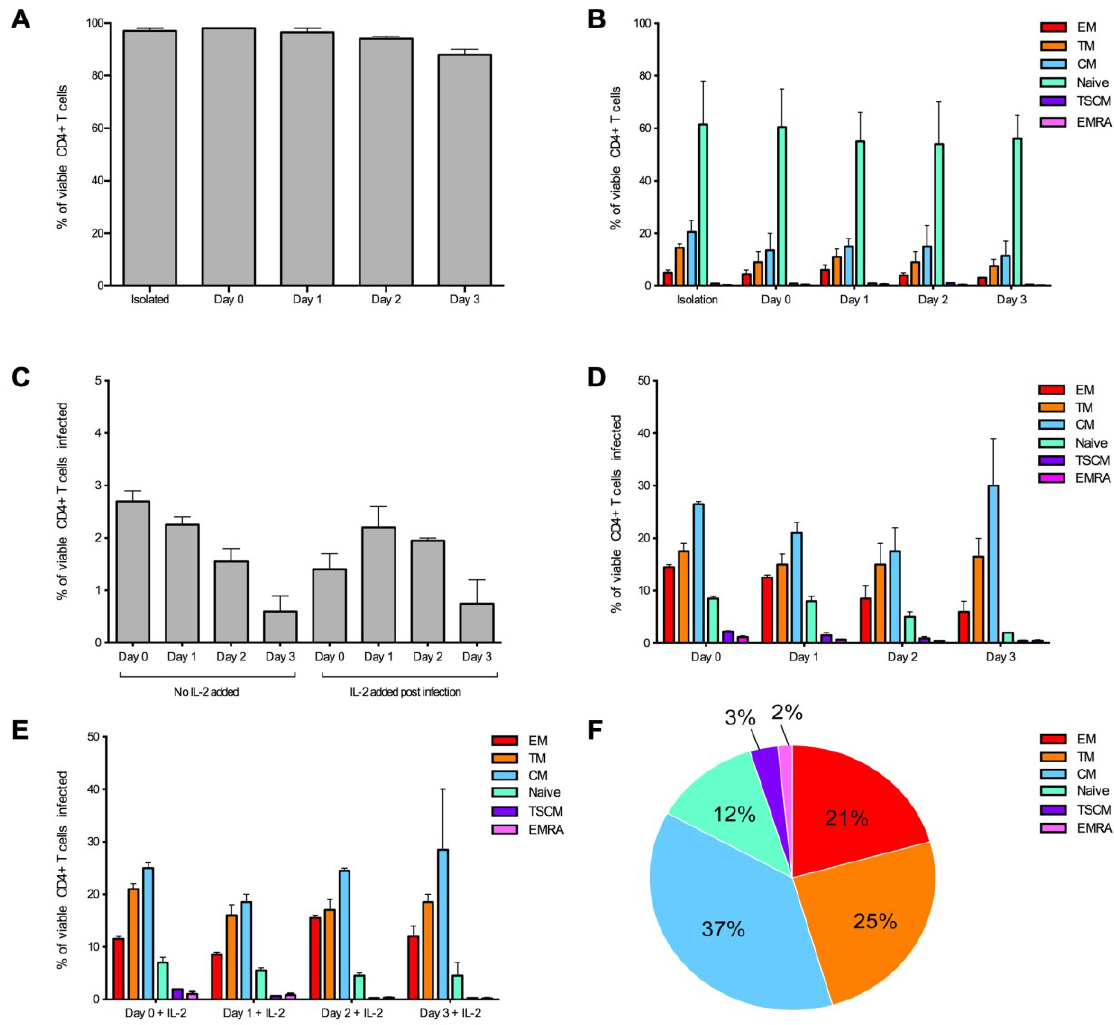
Figure 3. Optimization of the detection of infected CD4 + T cell subsets over time. CD4 +